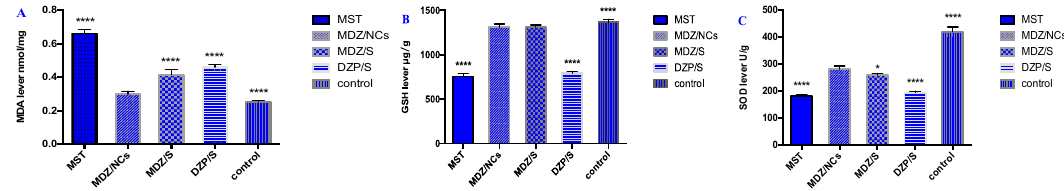
Figure 13. ( A ) Effect of MDZ/NCs on the MDA levels in the hippocampus of MST-induced convulsive rats. ( B ) GSH; ( C ) SOD. Note: The data represent the mean ± SD (n = 6); * p < 0.05; ****p < 0.01 compared with the MDZ/NC model group. Abbreviations: MDA, malondialdehyde; GSH, glutathione; SOD, superoxide dismutase.